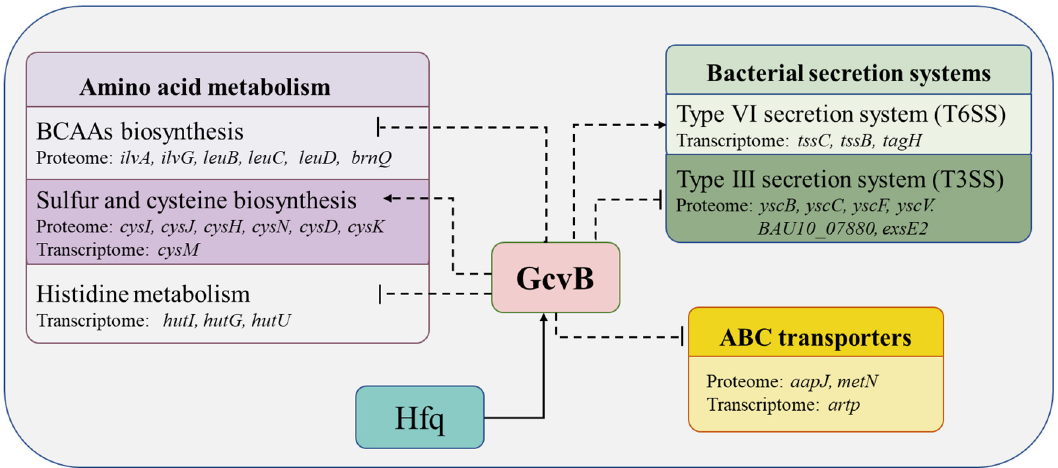
Figure 11. V. alginolyticus GcvB regulon. Boxes indicate major pathways regulated by GcvB. Solid arrows and bars indicate those that have been confirmed by EMSA. Dotted lines and bars show processes that have been confirmed by genetic or phenotypic analysis.